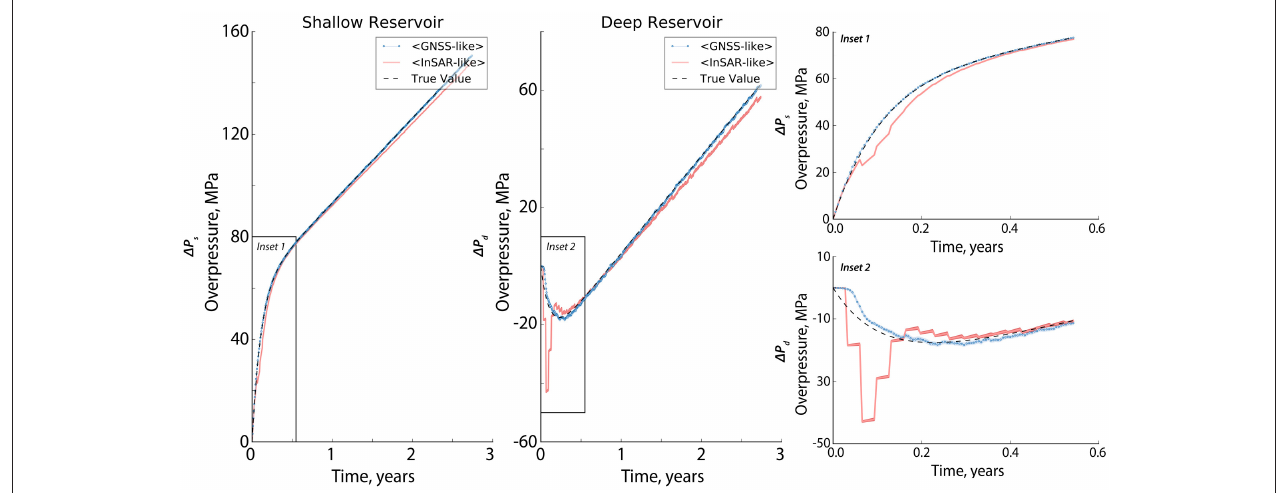
FIGURE 11 | Influence of the frequency of observations on the assimilation: GNSS (10 observations that are assimilated every time step, f obs the volcanic center ranging from 1 to 5 km) vs. InSAR-like dataset (242 observations that are assimilated every 12 days, f obs center ranging from 1 to 5 √ 2 km). Since parameter estimation is not possible to perform when InSAR dataset is used (see text), only the estimated overpressures are presented. Note that the initial conditions of the uncertain parameters are similar to those of in Figure 5C . The insets provide a closer image of the overpressures at the beginning of the assimilation. The light blue and red shades correspond to their spread (1 σ ). Note that these values are difficult to discern since they are very small when compared to the scale of the plot. The black broken lines represent the true